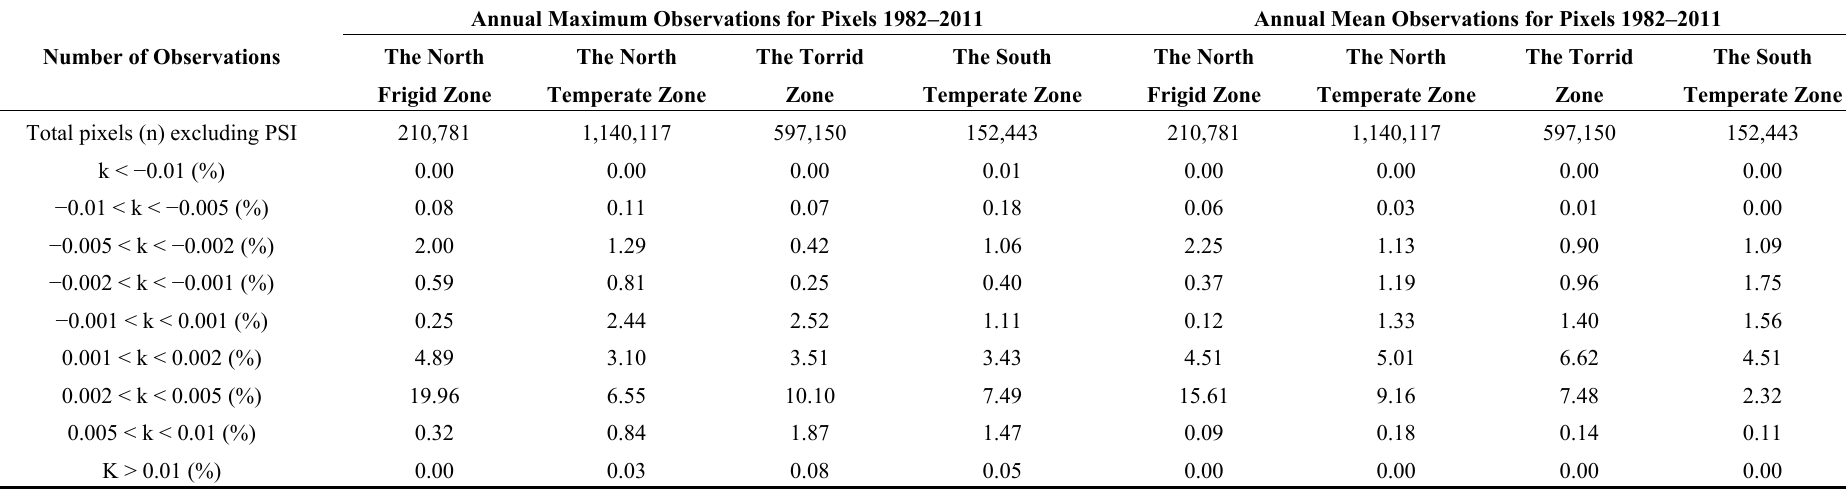
Table 5. Trend statistics for the GIMMS FVC Mann–Kendall analysis 1982–2011 ( p = 0.05) for all temperature zones in the